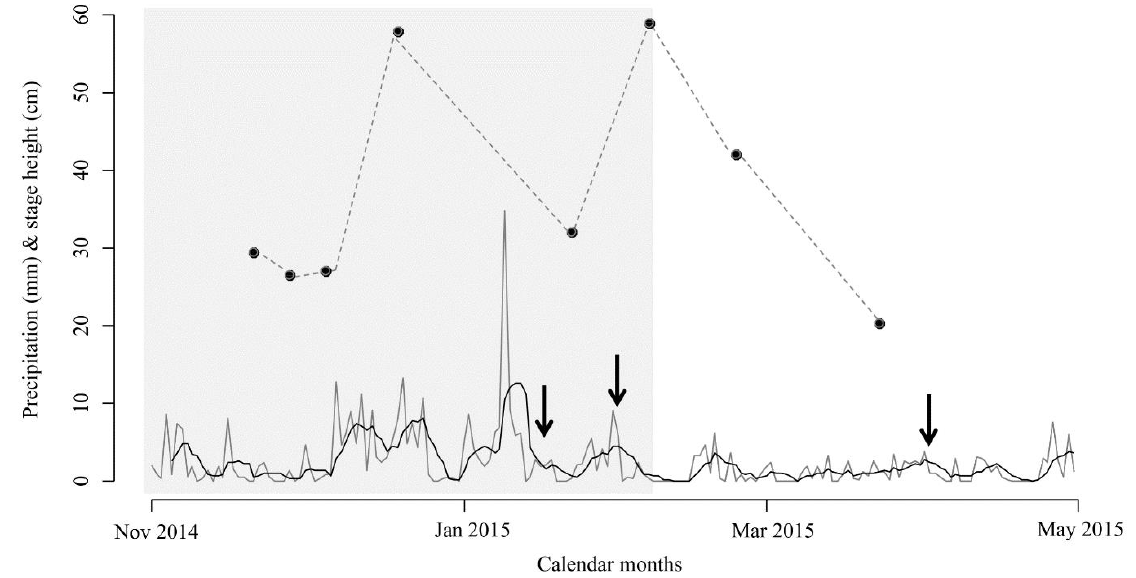
Figure 3. Stage height in cm (points and dashed line), daily precipitation in mm (solid grey line) and five- day average precipitation in mm (solid black line) during the sampling period November 2014 to May 2015, during which restoration management was undertaken (shaded area). The three sediment basket recovery dates are identified by the black arrows.